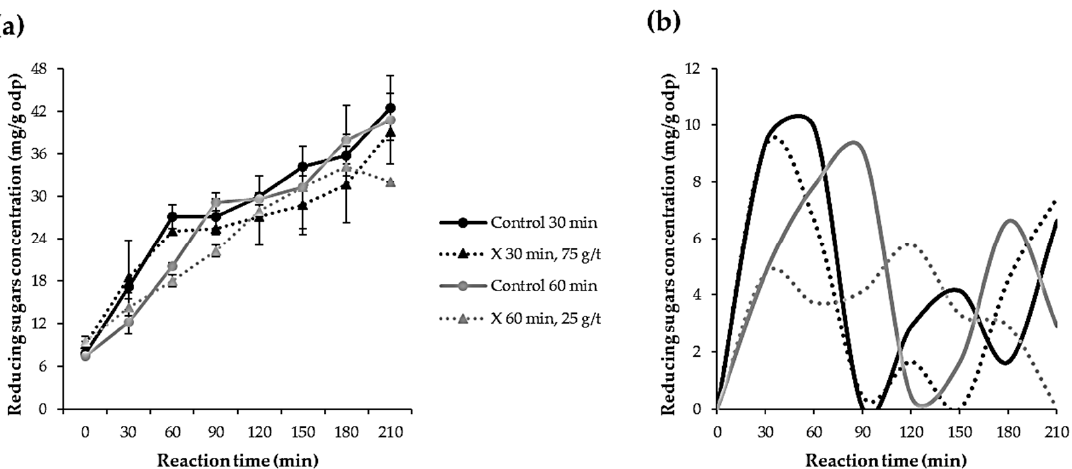
Figure 2. Cumulative ( a ) and fractional ( b ) reducing sugar release during the enzymatic peeling treatments.